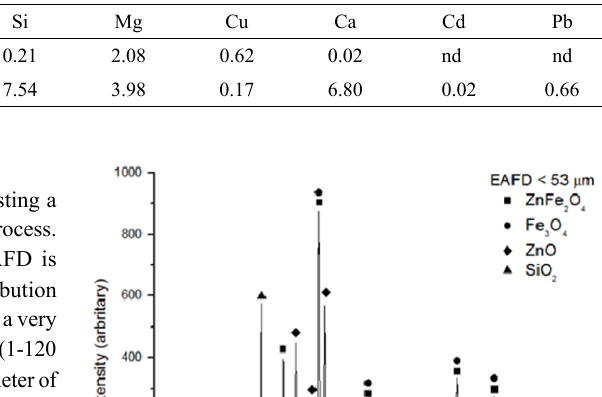
Figure 3a. EAFD are composed by irregularly-shaped particles (see arrows in Figure 3a) and smooth spherical (Figure 3b).